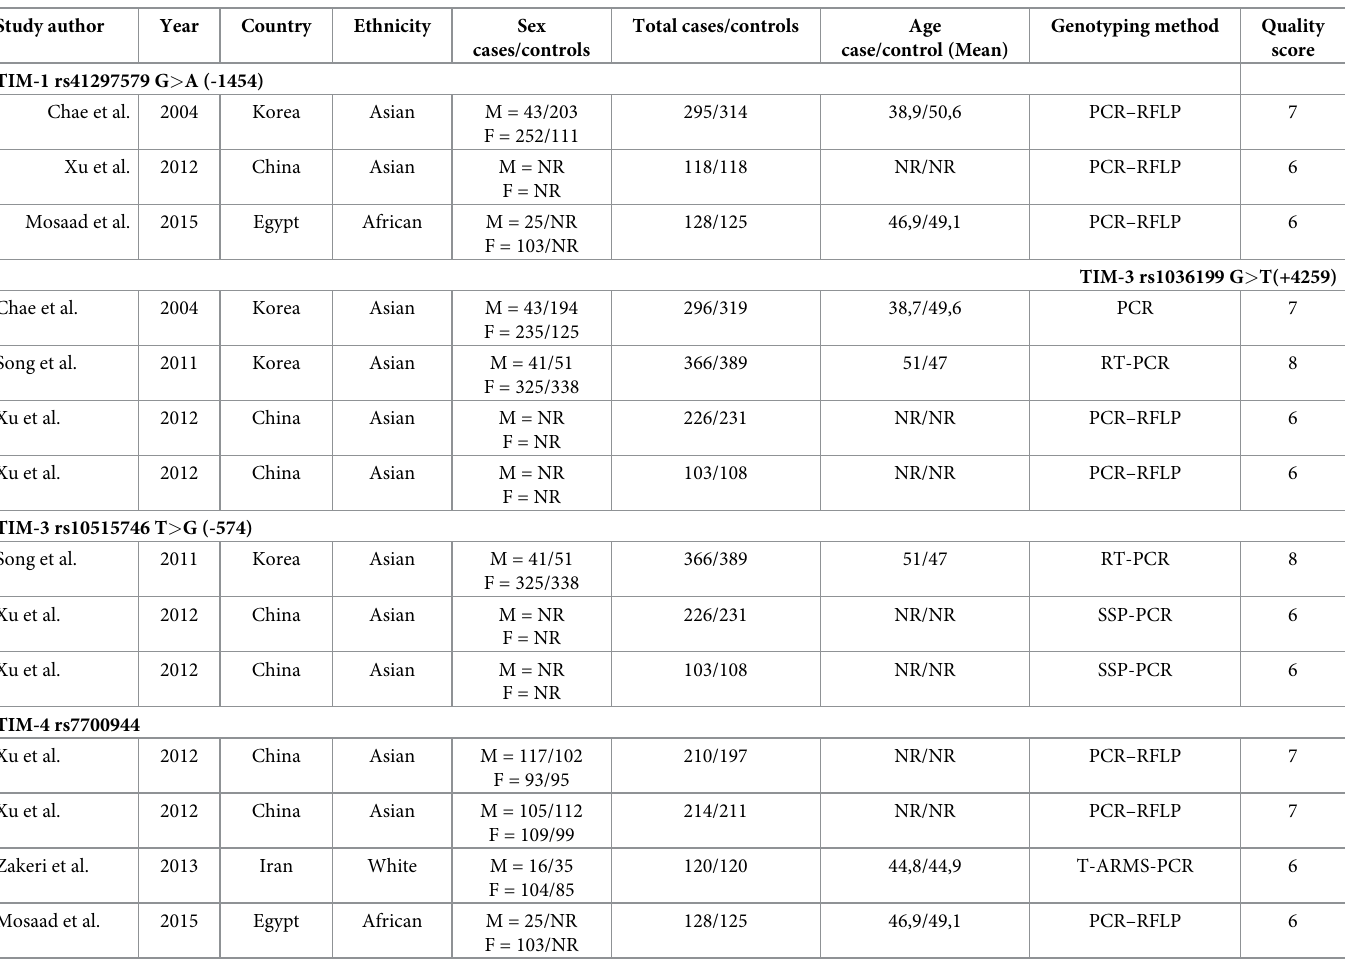
Table 1. Characteristics of studies included in meta-analysis of overall